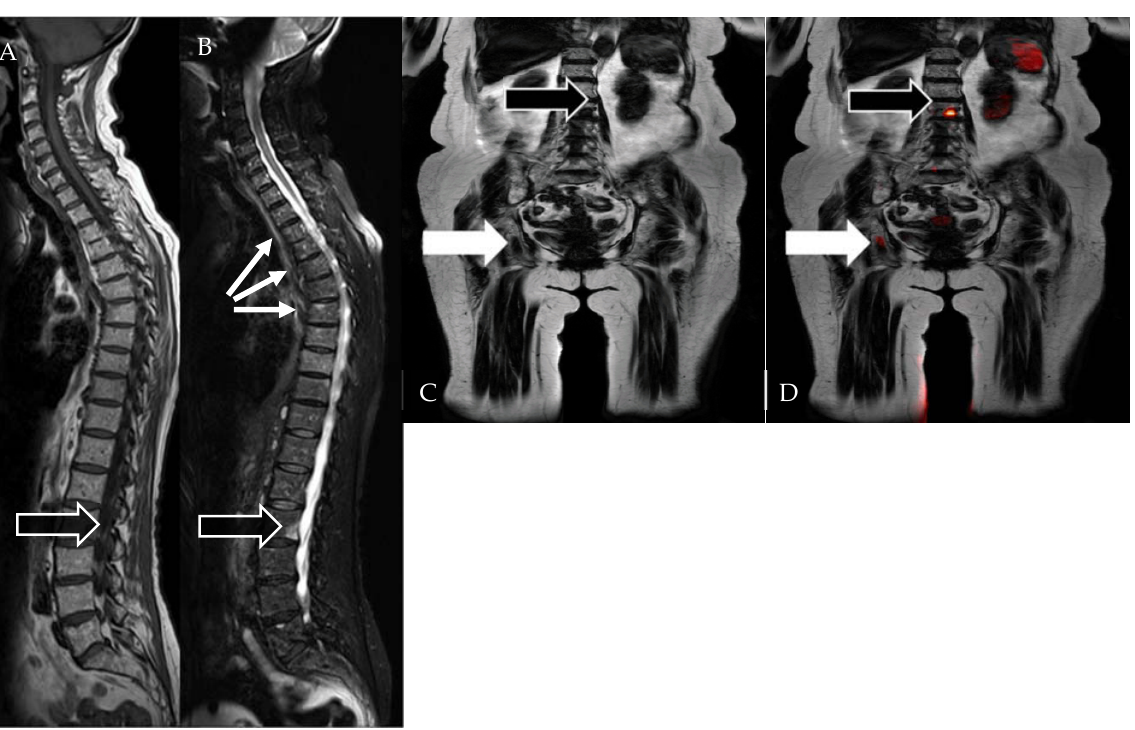
Figure 2. WB ‐ MRI in a 75 ‐ year ‐ old woman with mixed active and treated disease. ( A ) Sagittal T1 ‐ WI shows a lesion (black arrow) in the posterior and inferior L2 vertebral body. ( B ) Sagittal STIR image shows the L2 lesion (black arrow), as well as at several other sites of disease (thin white arrows) that were not obvious on the T1 ‐ WI. ( C ) Coronal T1 Dixon Fat image shows the L2 lesion (black arrow) and another lesion in the right ischium (white arrow). ( D ) Fused b800 ‐ Dixon image shows increased signal at L2 (black arrow) and to a lesser extent at the ischial lesion (white arrow).